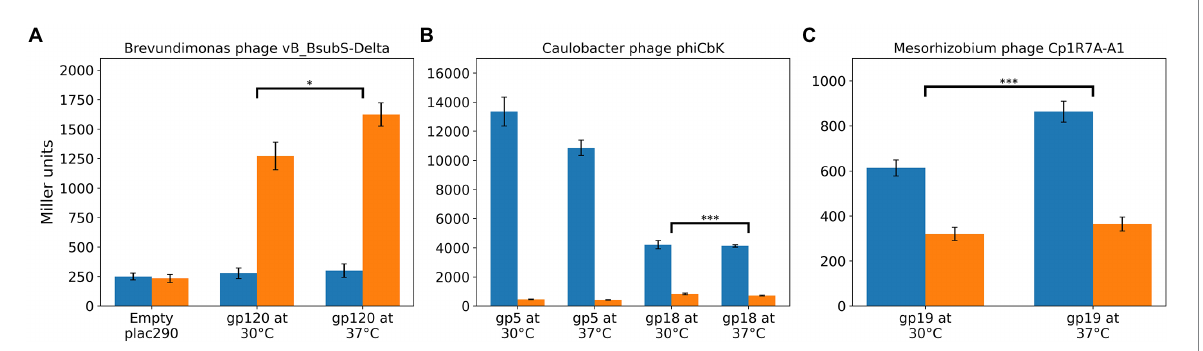
FIGURE 11 CtrA regulates gene expression in multiple LPEG phages. Standardized amount of β -Gal activity for C. crescentus cells harboring a plac290 vector containing the promoter region of target genes fused with a promoter-less beta-galactosidase gene. Blue and orange denote, respectively, results for the WT and temperature-sensitive CtrA LS2195 C. crescentus strains. (A) Expression levels for Brevundimonas phage vB_BsubS-Delta DELTA_120 genes. (B) Expression levels for Caulobacter phage Φ Cbk constructs for genes CbK_gp005 (gp5) and CbK_gp018